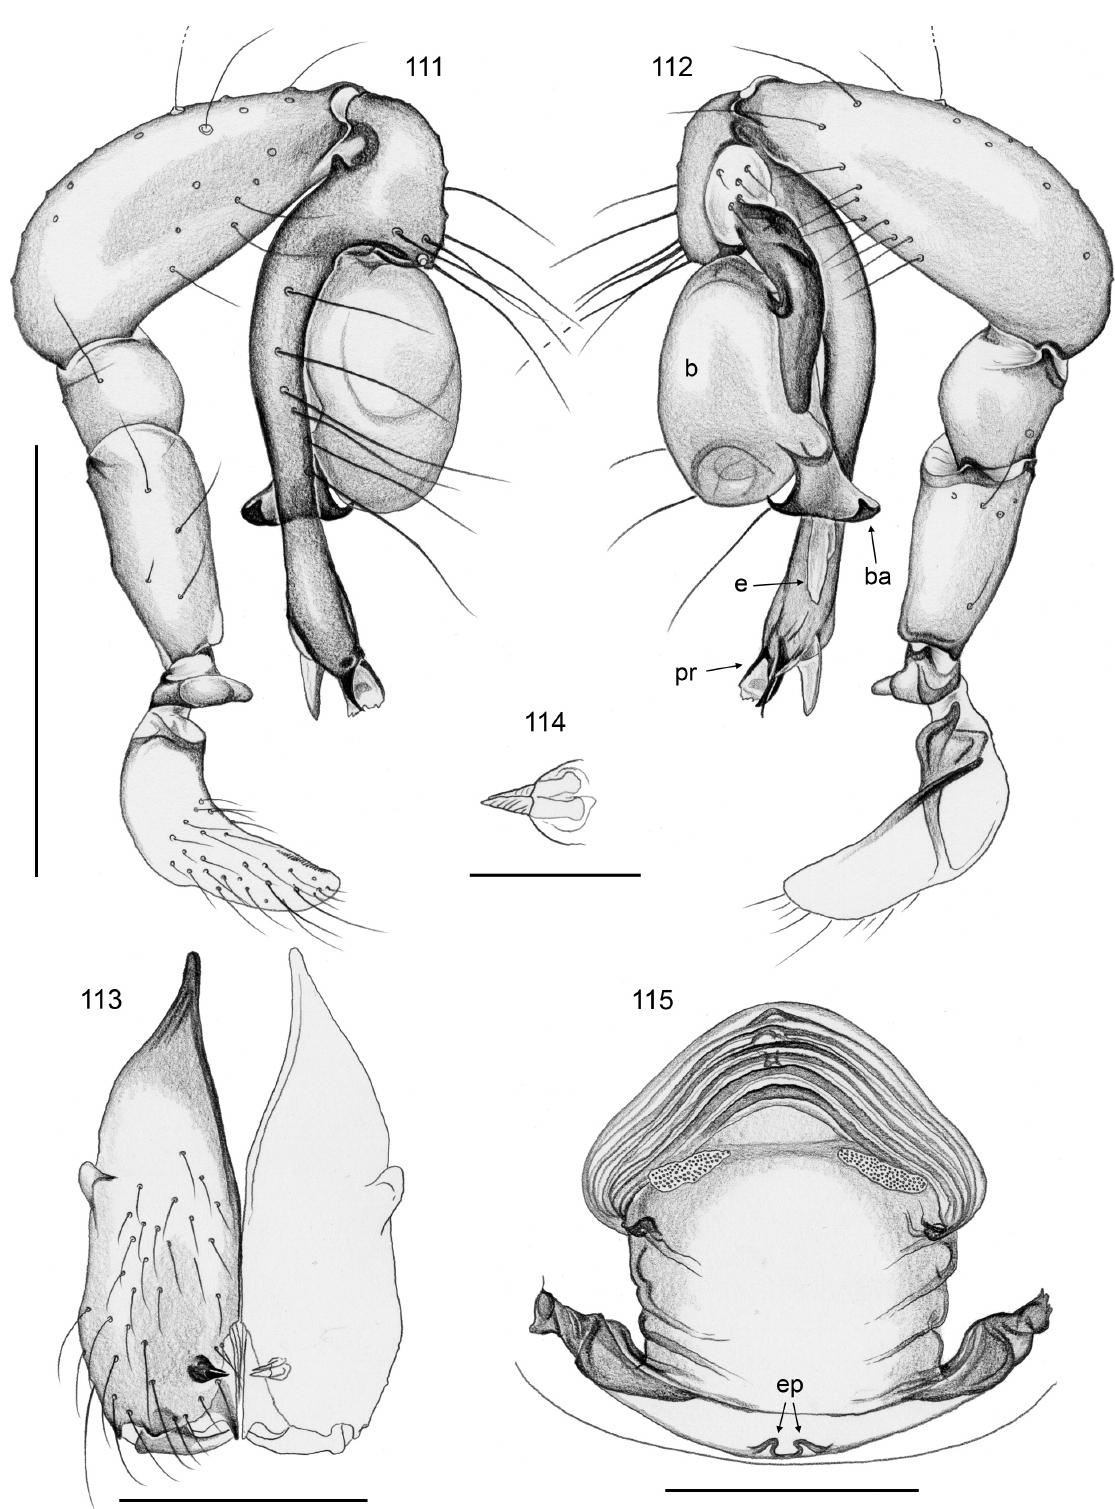
Figs 111-115. Quamtana nyahururu sp. nov. 111-112. Right ♂ palp, retrolateral and prolateral views. 113. ♂ chelicerae, frontal view. 114. ♂ cheliceral apophysis with modified hairs. 115. ♀ genitalia, cleared dorsal view. b: genital bulb; ba: bulbal apophysis; e: embolus; ep: epigynal pockets; pr: procursus. Scale lines: 0.05 mm (114), 0.2 mm (113, 115), 0.5 mm